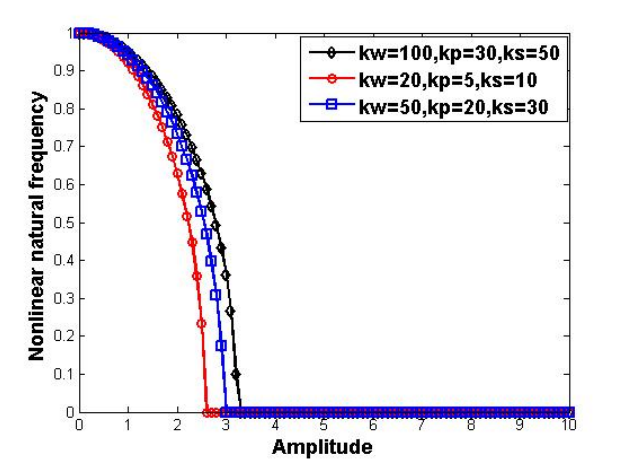
Figure 6. Influence of combine elastic foundations on nonlinear natural frequency